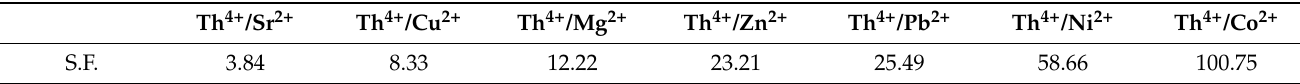
Table 3. The values of separation factor (S.F.) for Th 4+ versus seven metal ions.